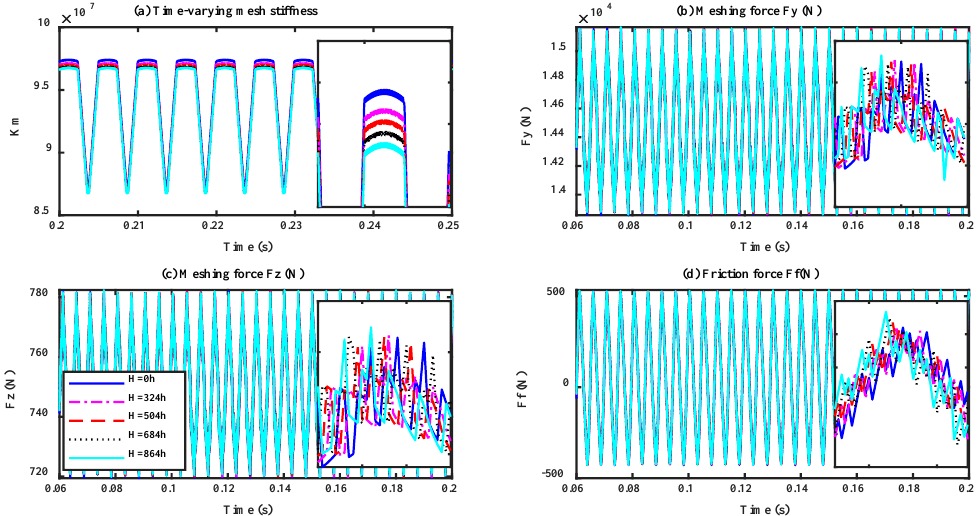
Figure 12. Gear meshing excitations.